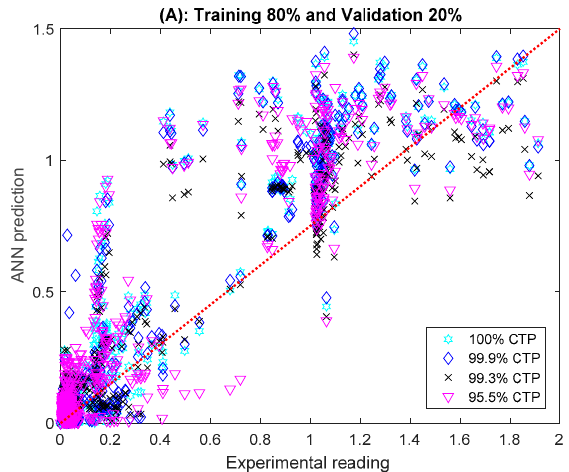
Figure 6. Performance evaluation of the experimental data with the predictions of the cross-validation ensemble ANN at the 95%, 99.3%, 99.9% and 100% levels of the Cumulative Target-component Percentage-influence (CTP) of the validation dataset.